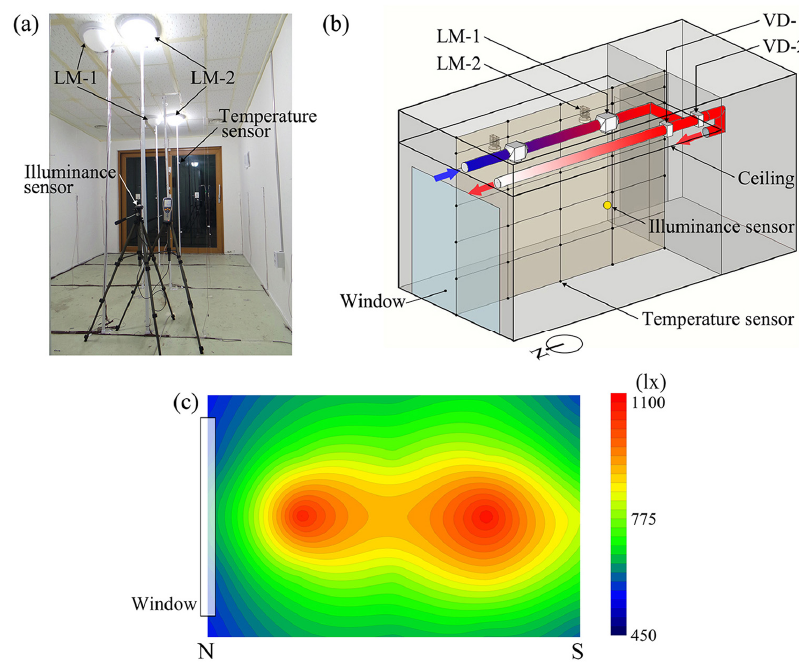
Figure 3. ( a ) Photograph of the mock-up chamber; ( b ) schematic view of the measurement points for temperature and illuminance; and ( c ) interior illuminance distribution at the task